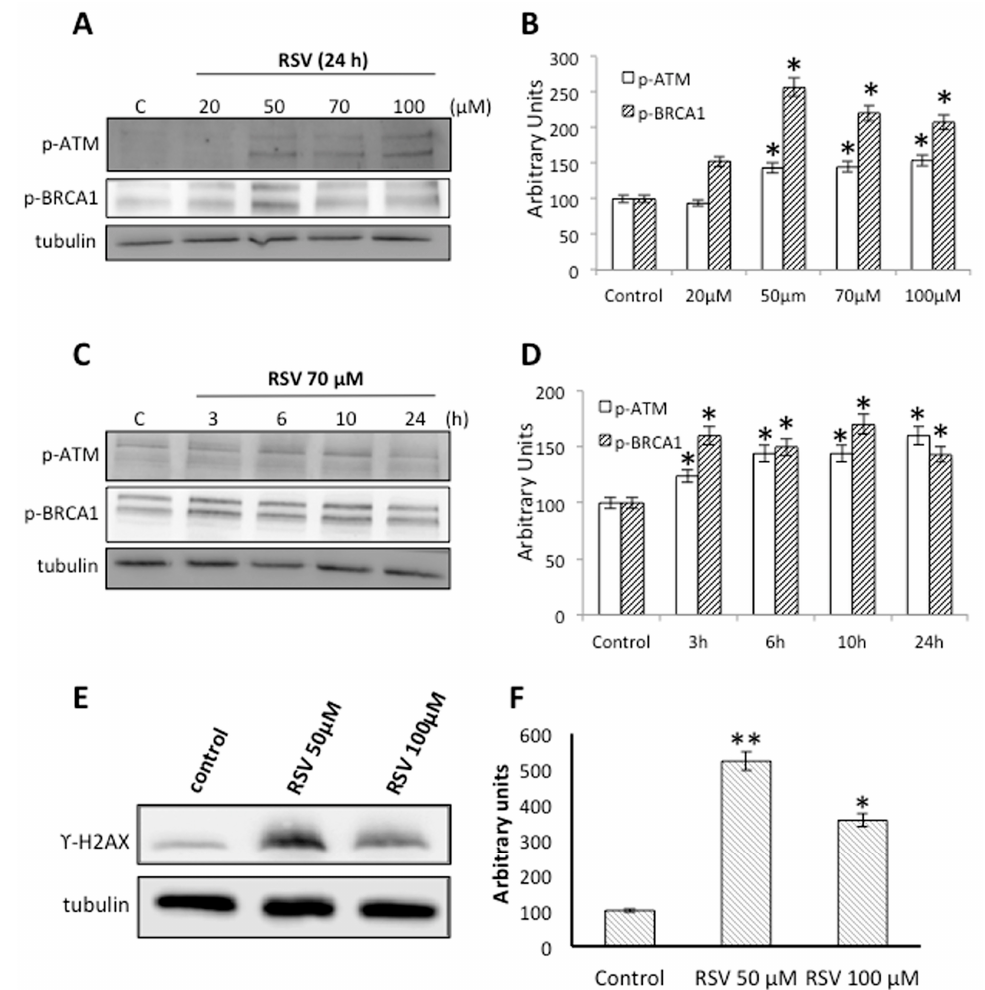
Figure 3. Effect of Resveratrol on the activation of the DNA damage response. ( A ) Western blot analysis of proteins from cells treated with different concentrations of resveratrol (RSV) for 24 h using anti-p-ATM (ataxia-telangiectasia mutated kinase) and anti-p-BRCA1 (breast cancer type 1 susceptibility protein) antibodies. Antibodies against total tubulin were used as loading control. ( B ) Quantification of the proteins shown in panel A is represented as a column plot with error bars. ( C ) Western blot analysis of proteins from cells treated with 70 µM RSV for different time periods using anti-p-ATM and anti-p-BRCA1 antibodies. Antibodies against total tubulin were used as loading control. ( D ) Quantification of the proteins shown in panel C is represented as a column plot with error bars. ( E ) Western blot analysis of proteins from cells treated with 50 µM or 100 µM RSV for 24 h using anti- γ -H2AX antibodies. Antibodies against total tubulin were used as loading control. ( F ) Quantification of the proteins shown in panel E is represented as a column plot with error bars. Results are representative of three independent experiments, * p < 0.05 compared to control cells.